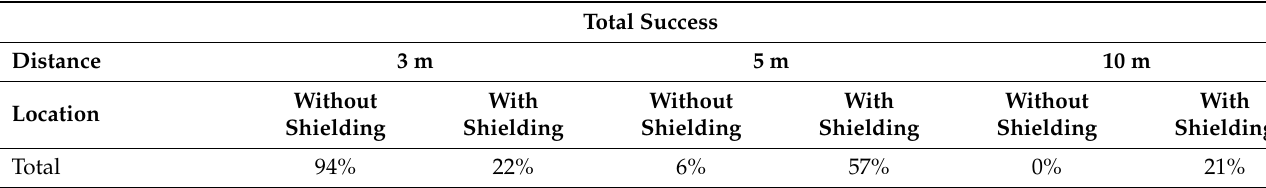
Table 5. Total success rate of distance